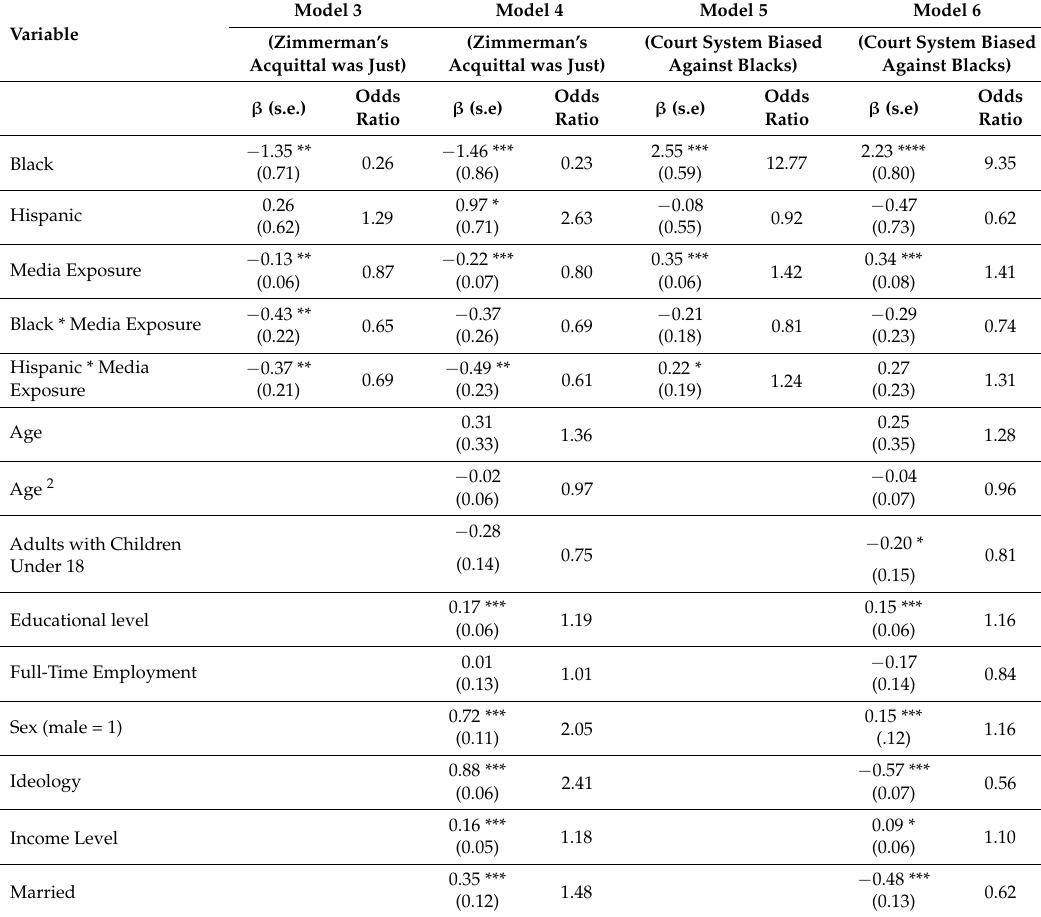
Table 3. Comparative Conflict Surrounding Perceptions of Injustice in the U.S. Court